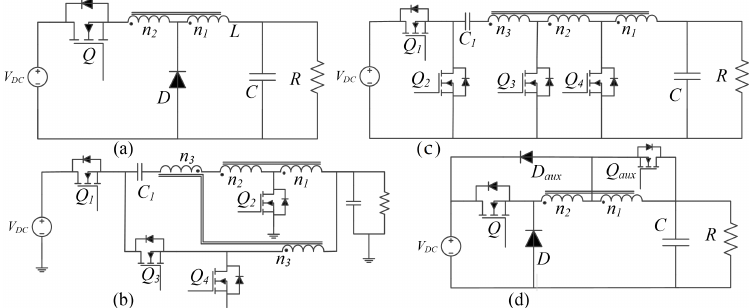
Figure 3. Tapped inductor based buck converters; ( a ) diode tapped inductor, ( b ) three-winding tapped inductor with series capacitor, ( c ) taped and coupled inductor converter and ( d ) tapped inductor with auxiliary